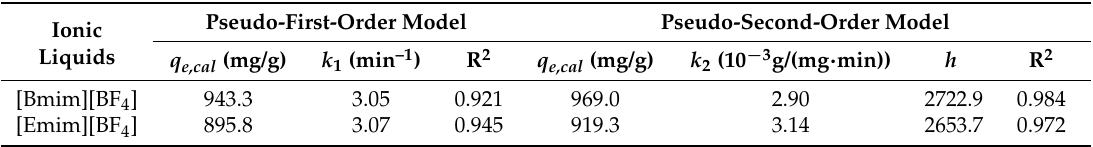
Table 5. Fitting parameters of kinetics (pseudo-first- and pseudo-second-order models) for